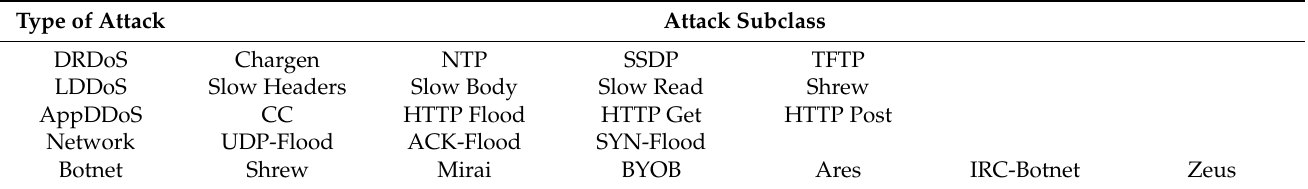
Table 4. Type of